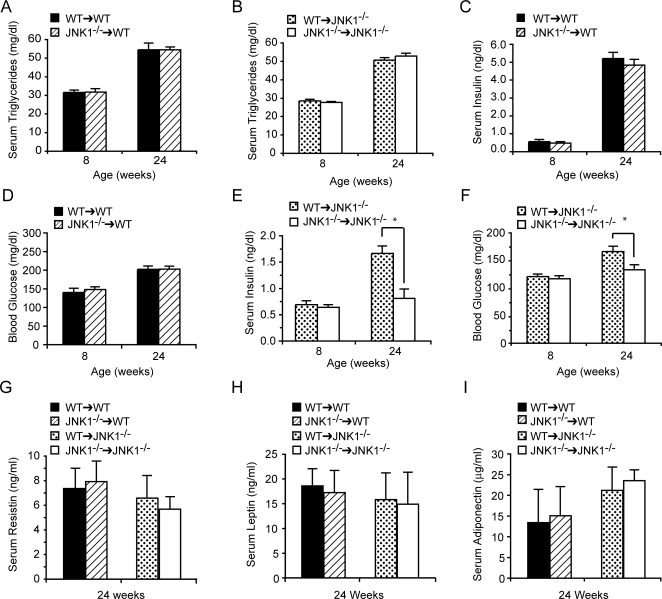
Steady state plasma lipid, glucose, insulin, and serum adipokine concentrations in JNK1-deficient chimeras.Serum samples were collected after a 6 hr food withdrawal from mice from the indicated chimeric groups at 8 and 24 weeks of age. Triglycerides were measured from WT (A) and Jnk1−/− recipients (B) transplanted with either WT or Jnk1−/− bone marrow. Serum insulin (C) and blood glucose (D) levels were measured in the WT recipient groups. Serum insulin (E) and blood glucose (F) levels measured in the Jnk1−/− recipient groups. Serum resistin (G), leptin (H), and adiponectin (I) levels measured in the WT and Jnk1−/− recipient groups at 24 weeks of age. Data are expressed as mean ± s.e.m. Asterisk indicates statistical significance (p<0.05) in Student's t test.